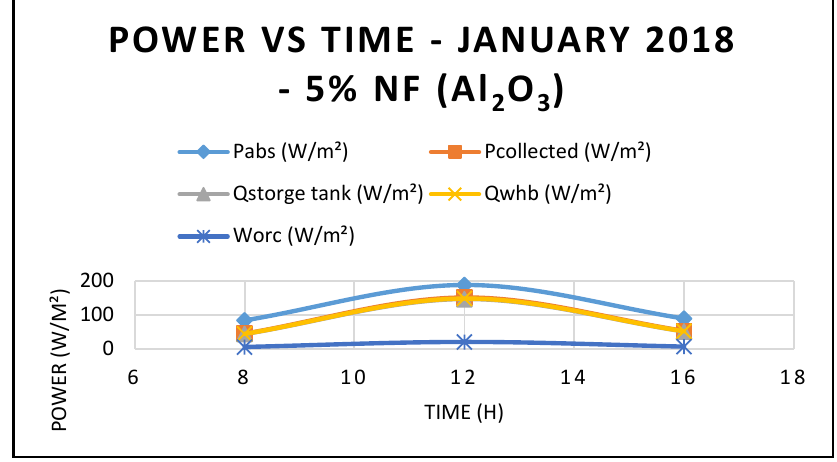
Figure 7. Characteristics of the CSP collector and hybrid system at concentration of 5% of Al 2 O 3.